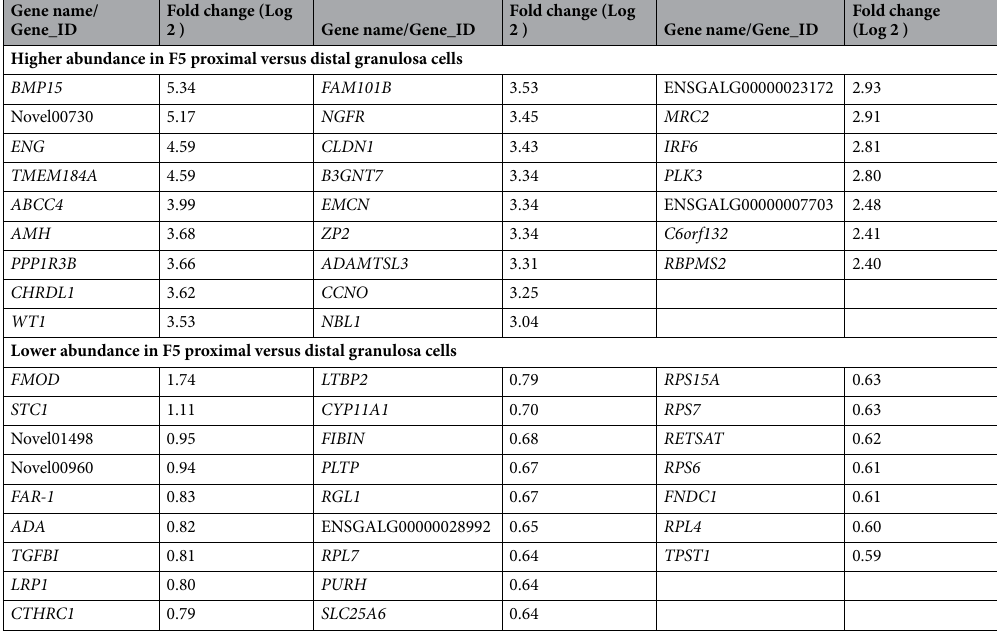
Table 2. Top 25 genes showing significant up or down regulation tendency in granulosa cells proximal and distal to the germinal disc (GD) in F5 follicles (q <